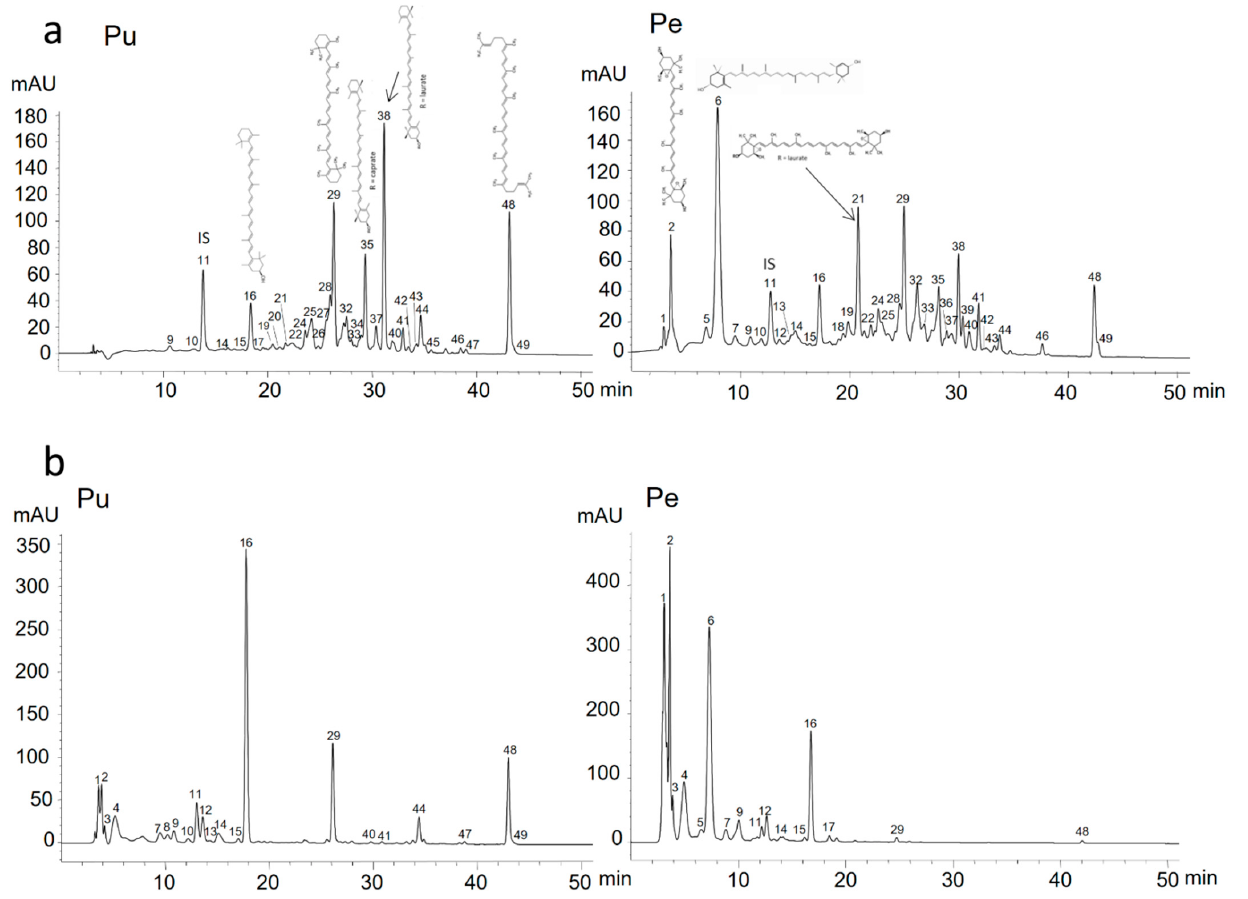
Figure 1. C 30 reversed-phase chromatogram of carotenoids of direct ( a ) or saponified extracts ( b ) obtained from pulp (PU) and peel (PE) of papaya fruits ( Carica papaya L.) cv. Sweet Mary, detected at 450 nm. Peak identities are shown in Table 2.